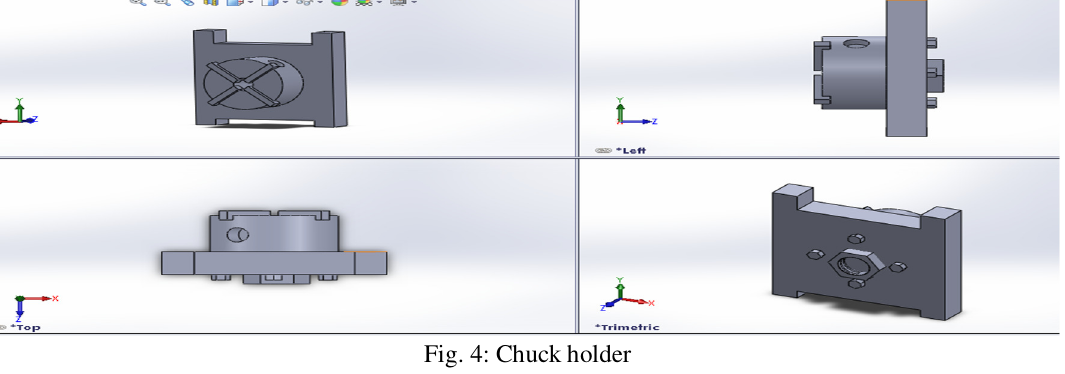
Fig. 4: Chuck holder